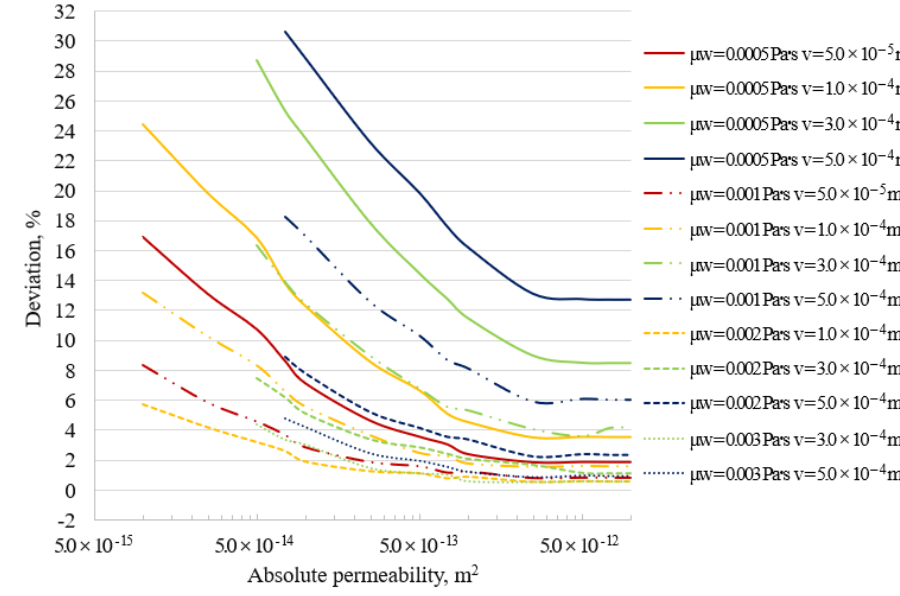
Figure 14. Distance deviation of Darcy equation versus Barree – Conway equation.